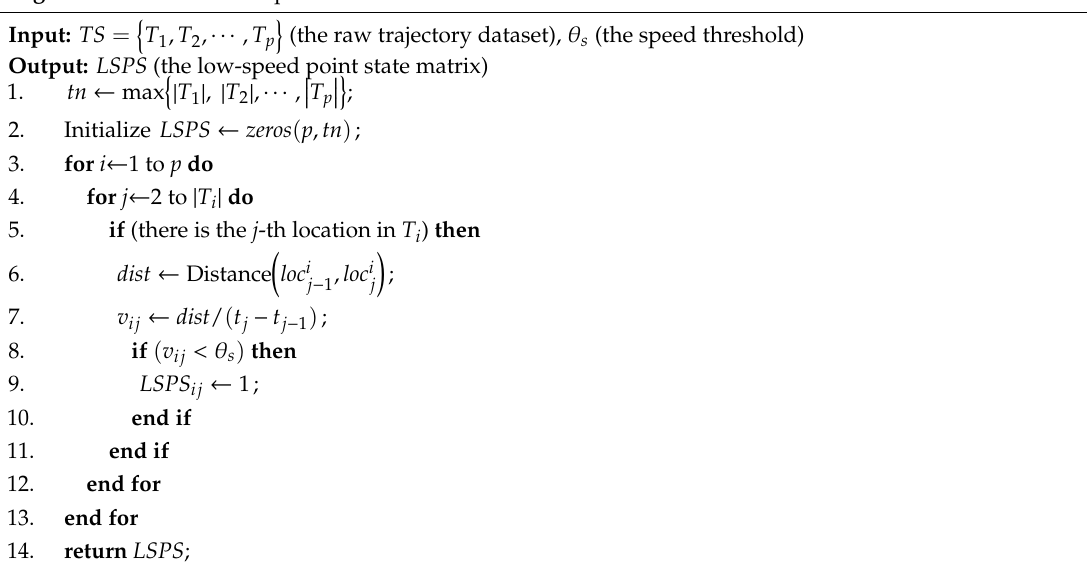
Algorithm 1. LPEX : Low-speed Points